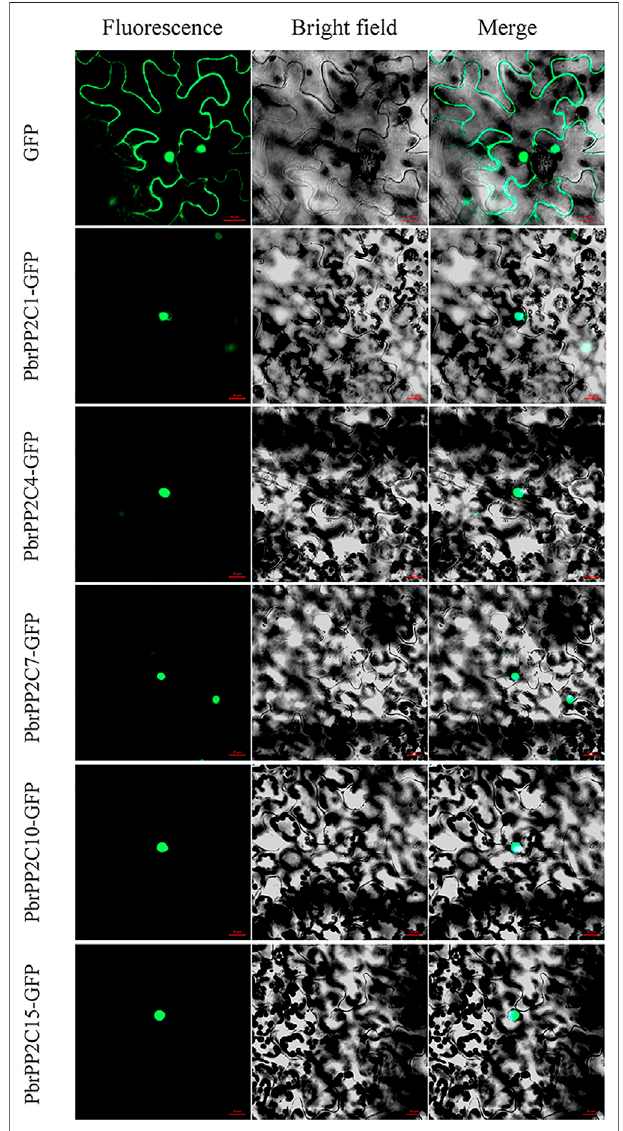
FIGURE7 | Subcellular localizationof the fusion protein PbrPP2Cs-GFP in N. benthamiana leaves. Vector 35S-GFP was used as the control. Bar (cid:1) 20 μ